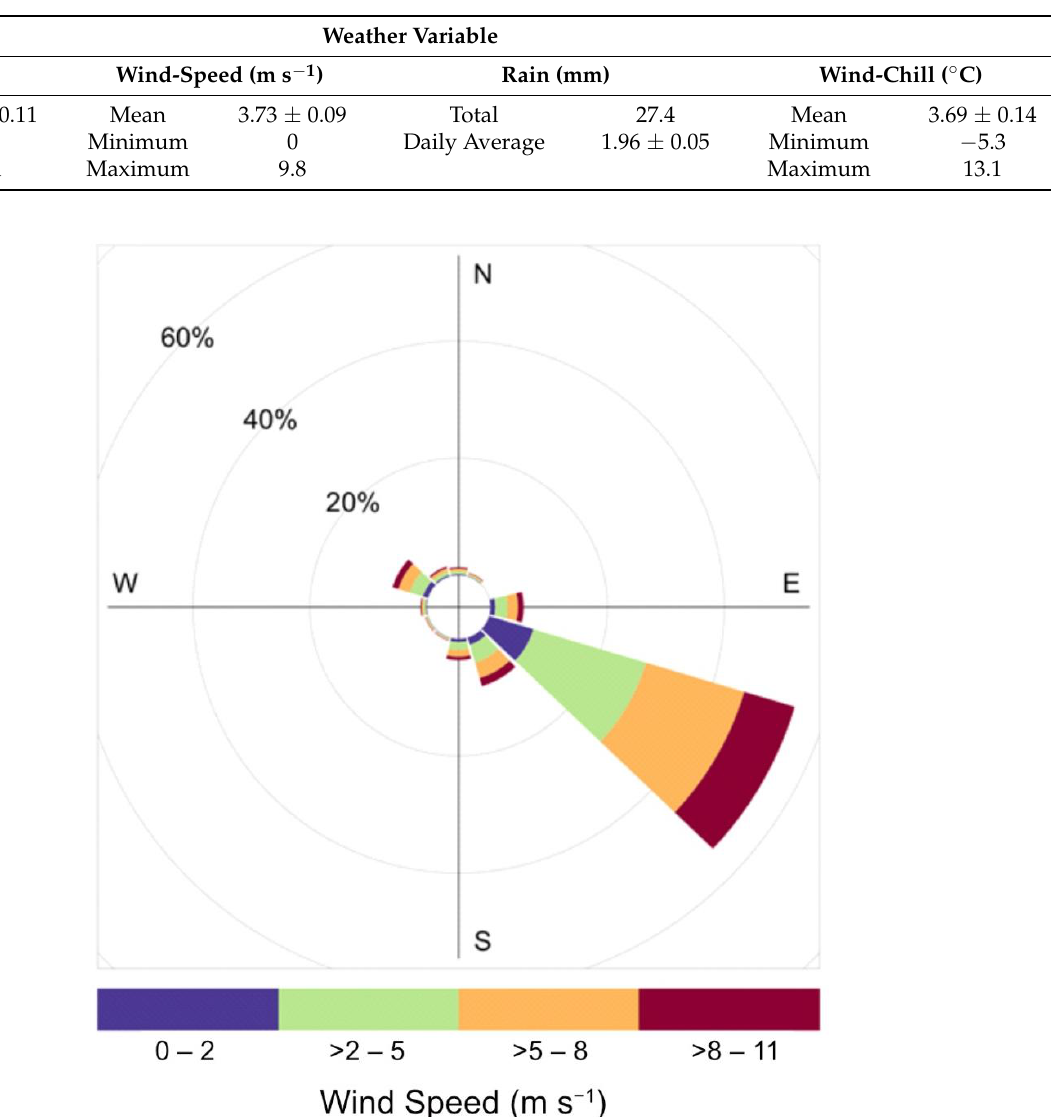
Figure 2. Predominant wind direction coming from the south-east and accompanying wind speeds during the study period (constructed using the openair R package [26]).